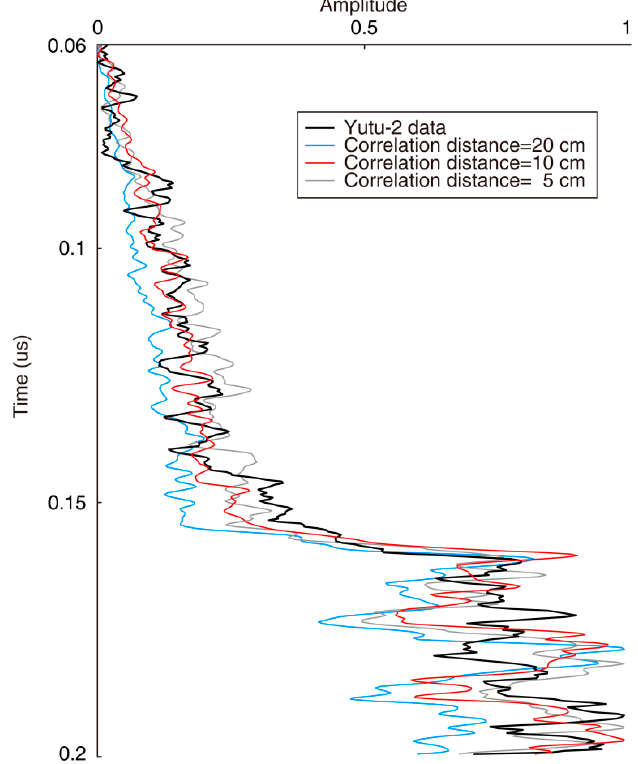
Figure 12. Comparison between stacked envelopes of the observed and synthetic LPR data with an RMS perturbation of 3%. The amplitude is normalized for each stacked envelope.